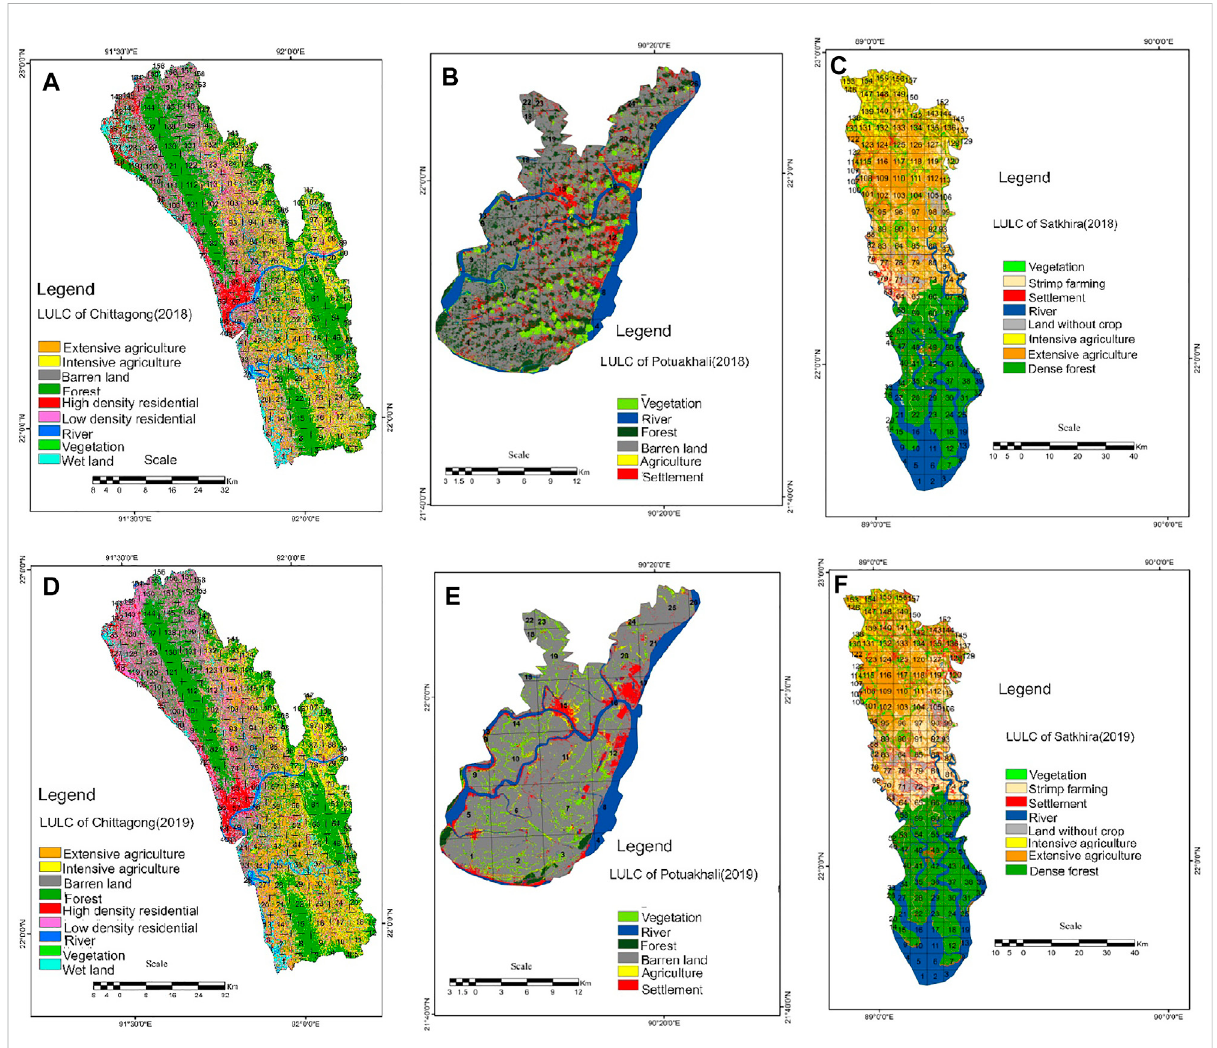
FIGURE 4 Extracted land use/land cover change from Landsat 8data of 2018 (upper)and 2019 (lower). (A andD) Grid-wise comparison of two respective years of Chattogram; (B and E) Patuakhali and (C and F) Satkhira. The comparative maps detect the spatial changes of land uses; in Chattogram, the north-easternpartandsouth-easternpartaremostlychanged;inSatkhira,transformationtookplaceinthenorthernandnorth-easternsection;and in Patuakhali, changed grids are mostly visible in the eastern part of the